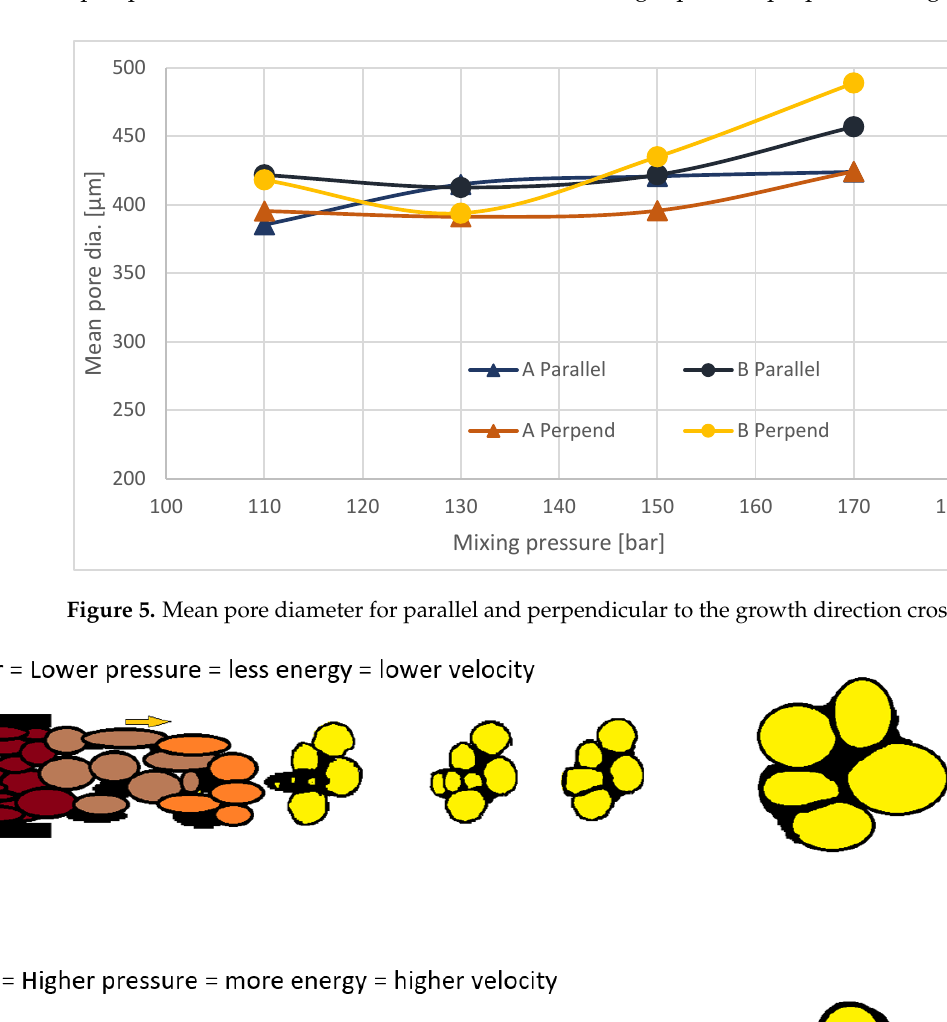
Figure 4. SEM cross-sectional images of foams synthesized at 170 bar, taken perpendicular and par- allel to the growth direction.